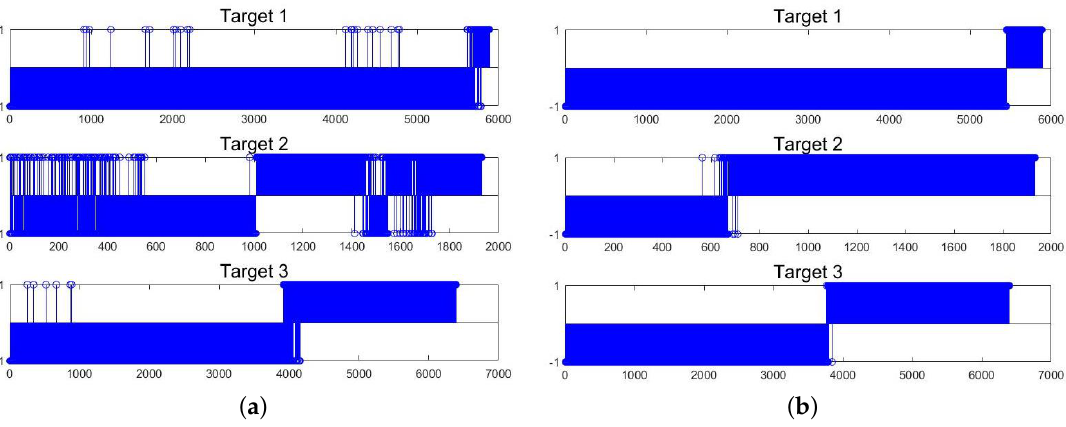
Figure 21. Detection results on Targets 1, 2, and 3 of Experiment 2 by using ( a ) SVDD and ( b ) the proposed method, where the label 1 and − 1 represent normal state and anomaly state,